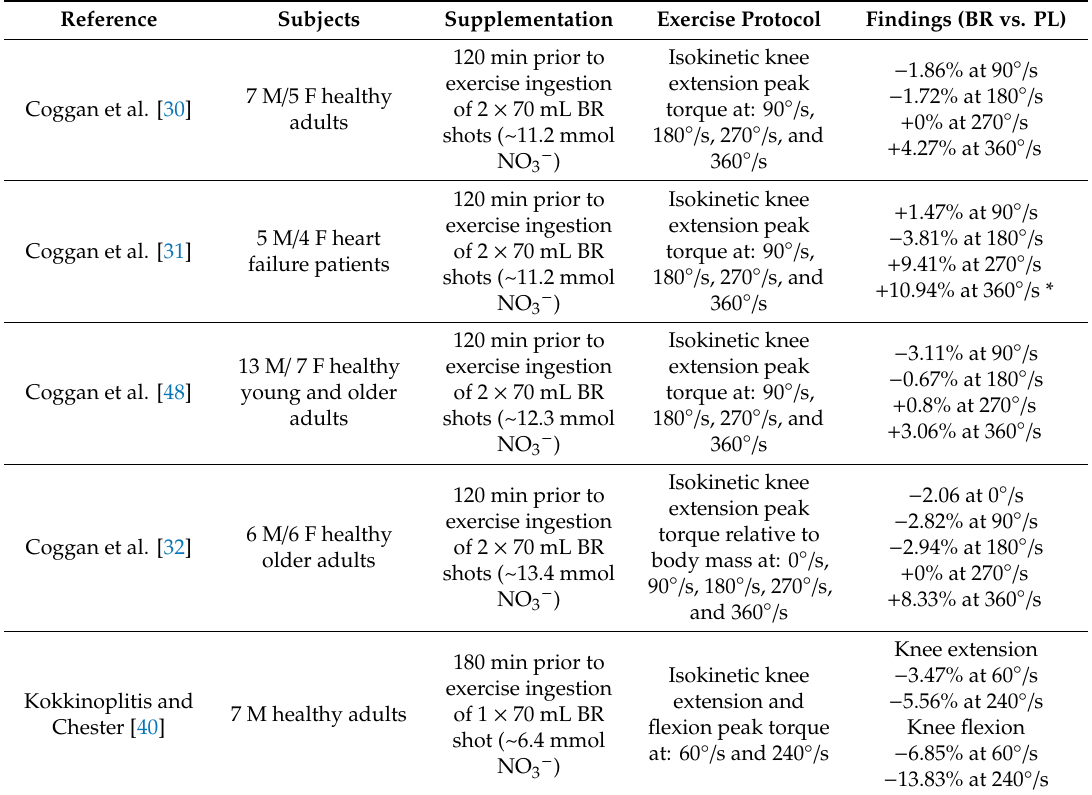
Table 1. Studies assessing the e ff ects of dietary NO 3 − supplementation on isokinetic peak torque production in